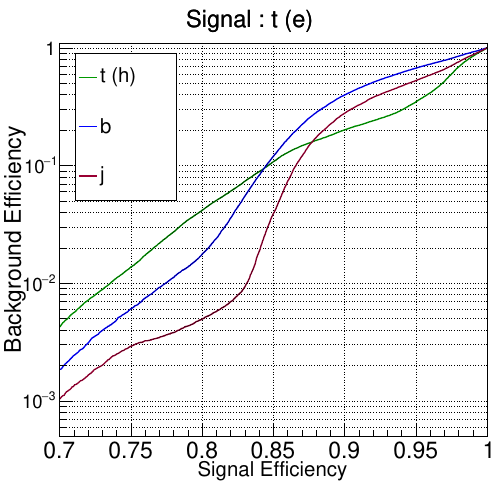
Figure 7 . Receiver operator characteristic (ROC) curves quantifying the performance of the BDT classi(cid:12)er to identify top jets, where the top quark decays to a (cid:12)nal state with electron, from various